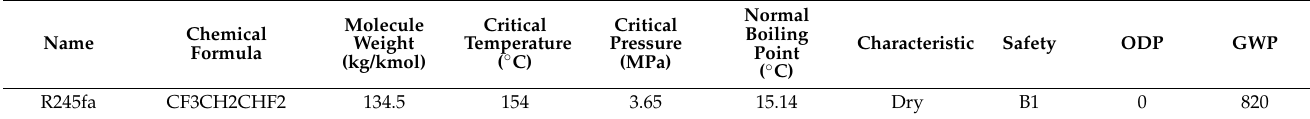
Table 7. Property of working